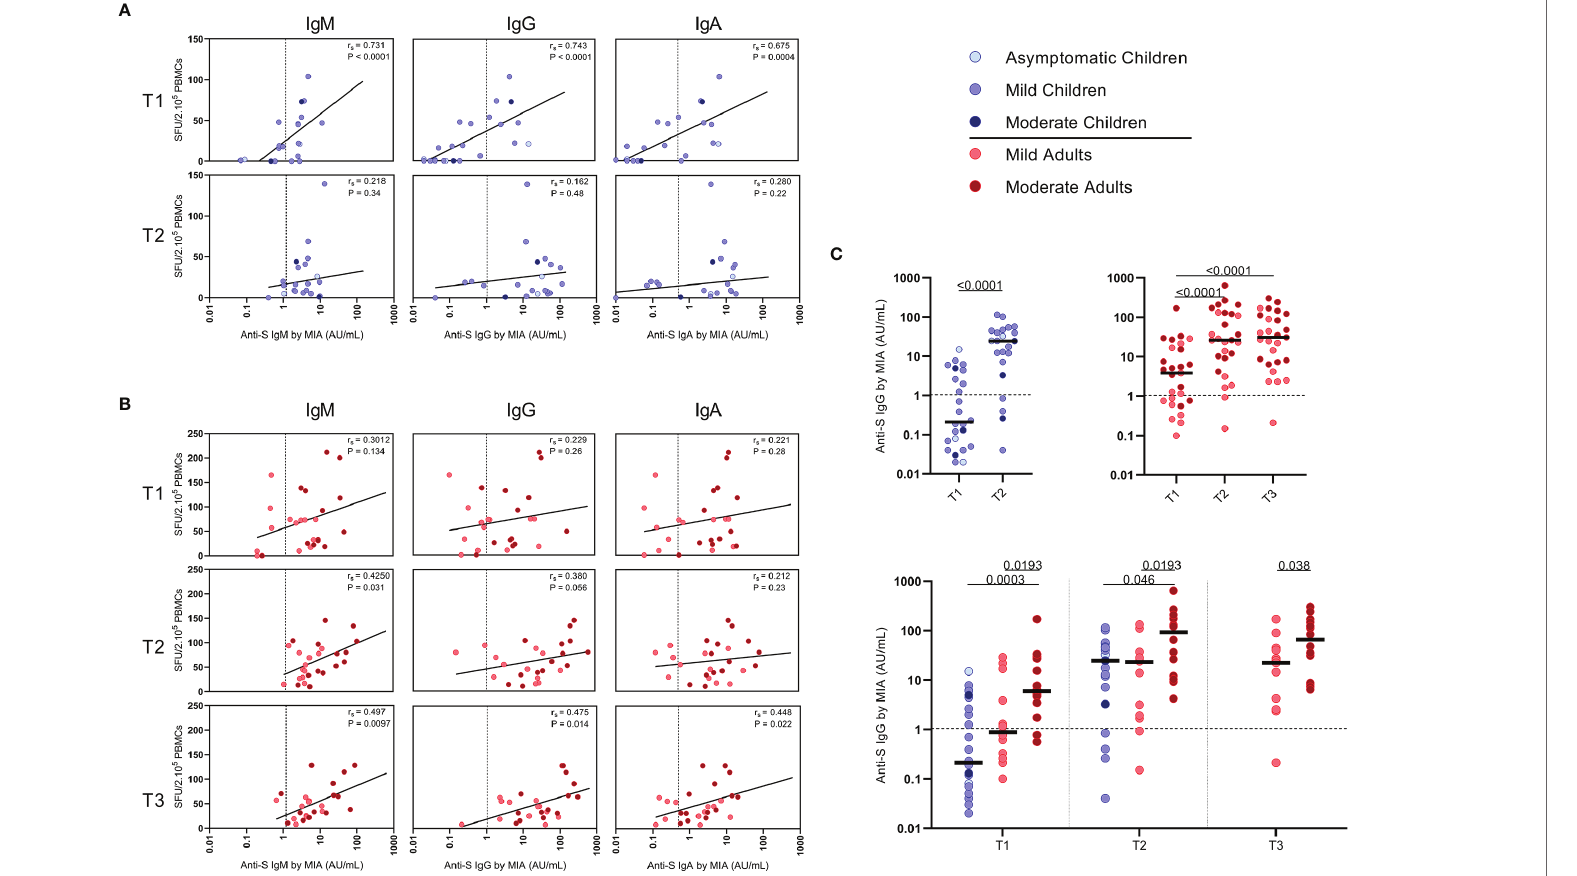
FIGURE 5 | Correlation between frequencies of SARS-CoV-2-speci fi c IFN- ɣ + T cells and antibody concentrations to S1-SARS-CoV-2. Spearman correlation between frequency of SARS-CoV-2-speci fi c IFN- ɣ + responder cells and concentrations of spike-S1 IgM, IgG, or IgA serum antibodies measured by multiplex immunoassay (MIA) at different time points after infection in (A) children and (B) adults. Concentrations of spike-S1 IgG serum antibodies at the various time points after SARS-CoV-2 infection in the whole group of children and adults ( C , upper panel) and in the whole group of children versus the mild and moderate adult cases ( C , lower panel). Cut-off values for seroprevalence are indicated with vertical or horizontal dotted lines. Each dot represents one subject. Correlation coef fi cients (rs) were determined with Spearman ’ s rank correlation. P values < 0.05 were considered signi fi cant. Differences in IgG concentrations for paired data were compared using the Wilcoxon signed-rank test (for comparison of two paired groups) (infected children at T1 versus T2) or the Friedman test with Dunn ’ s multiple comparison tests (infected adults at T1 versus T2 versus T3). For unpaired comparisons, Mann-Whitney U test (two-group comparisons) (mild adults versus moderate adults) or Kruskal-Wallis rank-sum test with Dunn ’ s post hoc test for multiple comparisons were used (children versus mild adults versus moderate adults; at T1 versus T2 versus T3). Statistically signi fi cant comparisons are indicated, with P values < 0.05 considered signi fi cant. T1, fi rst timepoint of sampling for adults median 12.5 days and children median 8 days post-symptom onset; T2, 10-14 days after T1; T3, 4-6 weeks after